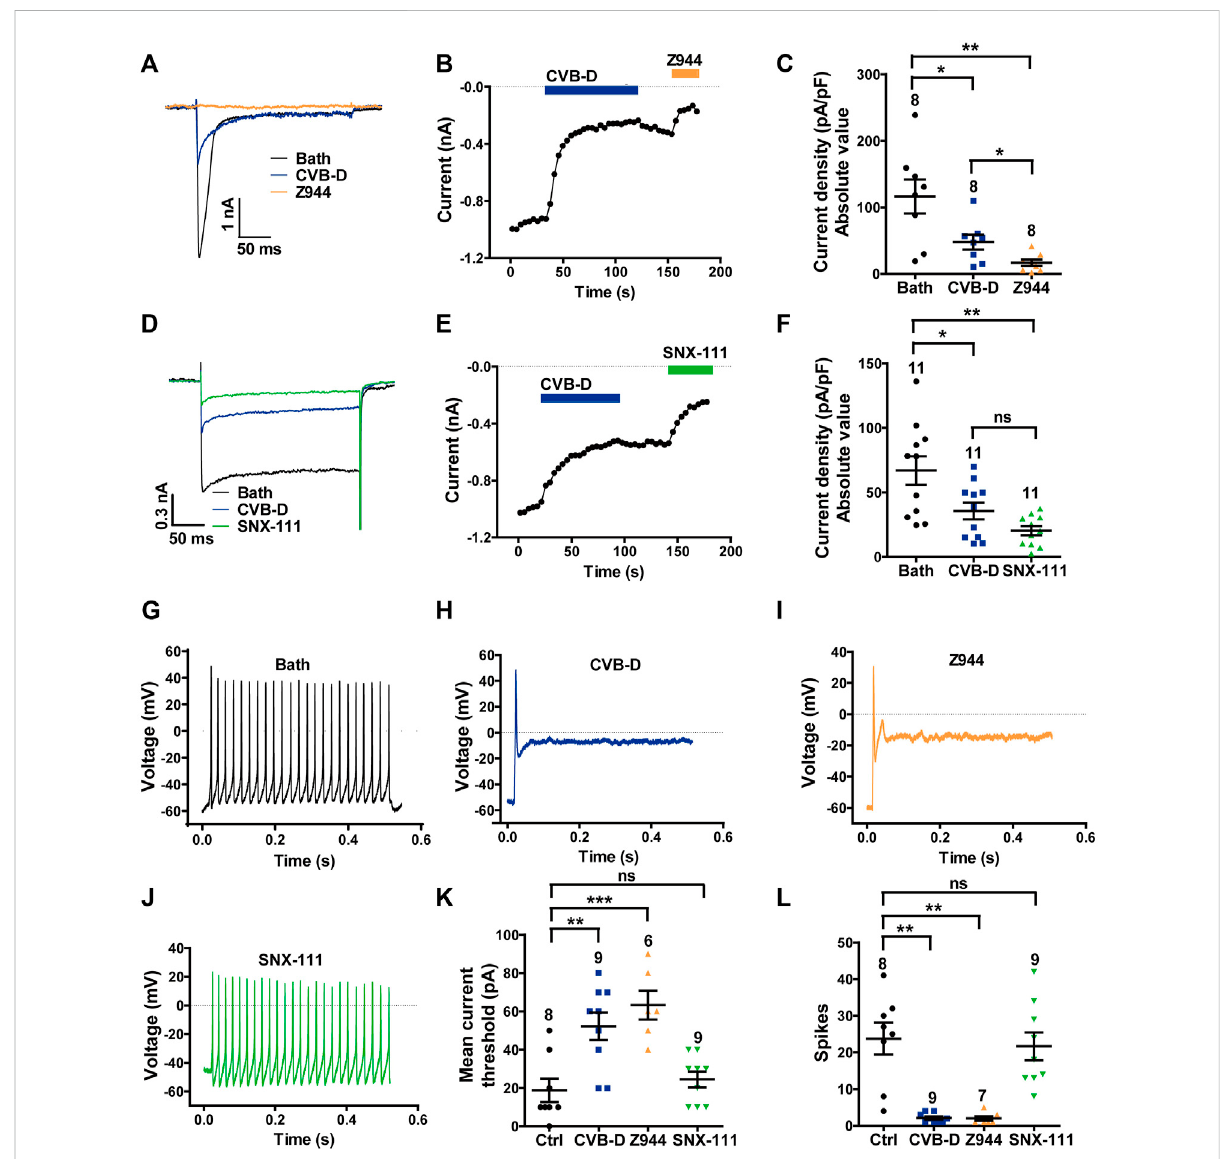
FIGURE 5 Effect of CVB-D on DRG neuron calcium channel currents and excitability. (A) Representative LVA (Ca v 3.2) Ca 2+ channel peak currents evoked by 250-ms depolarizations to -40 mV (from a HP of -100 mV) after treatment of bath (black), CVB-D (10 μ M, blue) or Z944 (5 μ M, orange). (B) Time course of inhibition by CVB-D (10 μ M, blue) and subsequent inhibition by Z944 (5 μ M, orange) of LVA (Ca v 3.2) Ca 2+ channel peak current. (C) Quanti fi cation of LVA (Ca v 3.2) Ca 2+ channel current densities from neurons treated with bath (black), CVB-D (blue) or Z944 (orange). (D) Representative HVA (Ca v 2.2) Ca 2+ channel peak currents evoked by 250-ms depolarizations to +10 mV (from a HP of -100 mV) after treatment of bath(black),CVB-D(10 μ M,blue)orSNX-111(0.5 μ M,green). (E) TimecourseofinhibitionbyCVB-D(10 μ M,blue)andsubsequentinhibitionbySNX- 111(0.5 μ M,green)ofHVA(Ca v 2.2)Ca 2+ channelpeakcurrent. (F) Quanti fi cationofHVA(Ca v 2.2)Ca 2+ channelcurrentdensitiesfromneuronstreated withbath(black),CVB-D(blue)orSNX-111(green). (G – J) RepresentativerecordingofAP fi ringevokedbyathresholddepolarizingcurrentinneurons in the presence of bath (G) , 30 μ M CVB-D (H) , 5 μ M Z944 (I) , or 0.5 μ M SNX-111 (J) . (K) Effect of CVB-D (blue), Z944 (orange) or SNX-111 (green) on the mean current threshold to induce AP fi ring in neurons. (L) Effect of CVB-D (blue), Z944 (orange) or SNX-111 (green) on the mean number of AP fi ring(spikes)inneuronsevoked byathreshold depolarizing current.Data information: Thenumberineachgraphindicatesthenumberofcells used in each experiment. Statistical signi fi cance was evaluated using two-tailed t -test (for two-group comparisons) or one-way analysis of variance (ANOVA) followed by Tukey ’ s test and LSD test (for multi-group comparisons), with * p < 0.05, ** p < 0.01, and *** p < 0.001; ns indicates no signi fi cance. The exact t, F, and p -values are indicated in Appendix Table S1. All the data are presented as mean ±